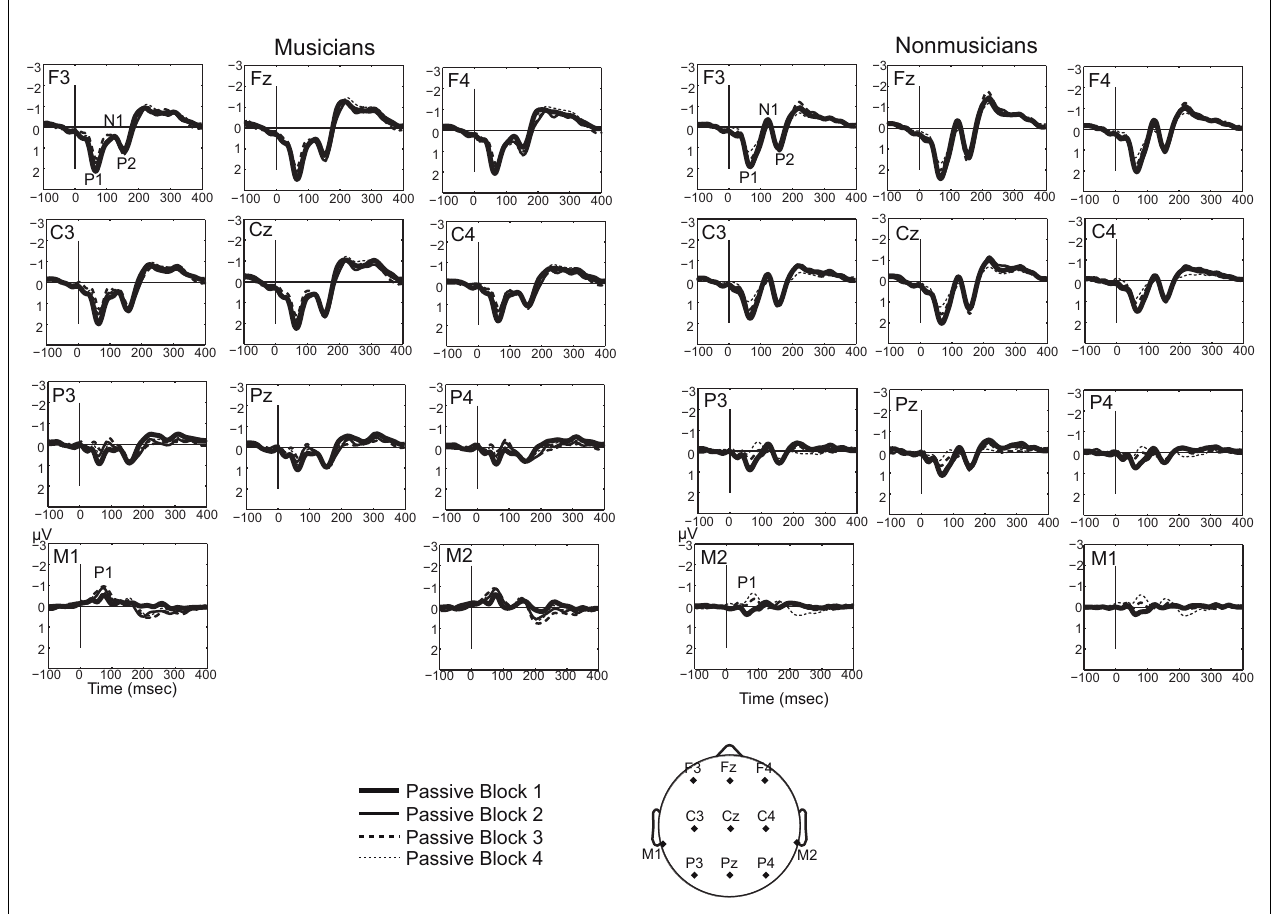
FIGURE 4 | Grand average waveforms for standard sounds for musicians and non-musicians. Grand averages are presented for nose-referenced Fz, Cz, Pz (and their right and left hemisphere electrodes) and right and left mastoids. Mastoid electrodes show a negative polarity in the P1 and P2 time window.